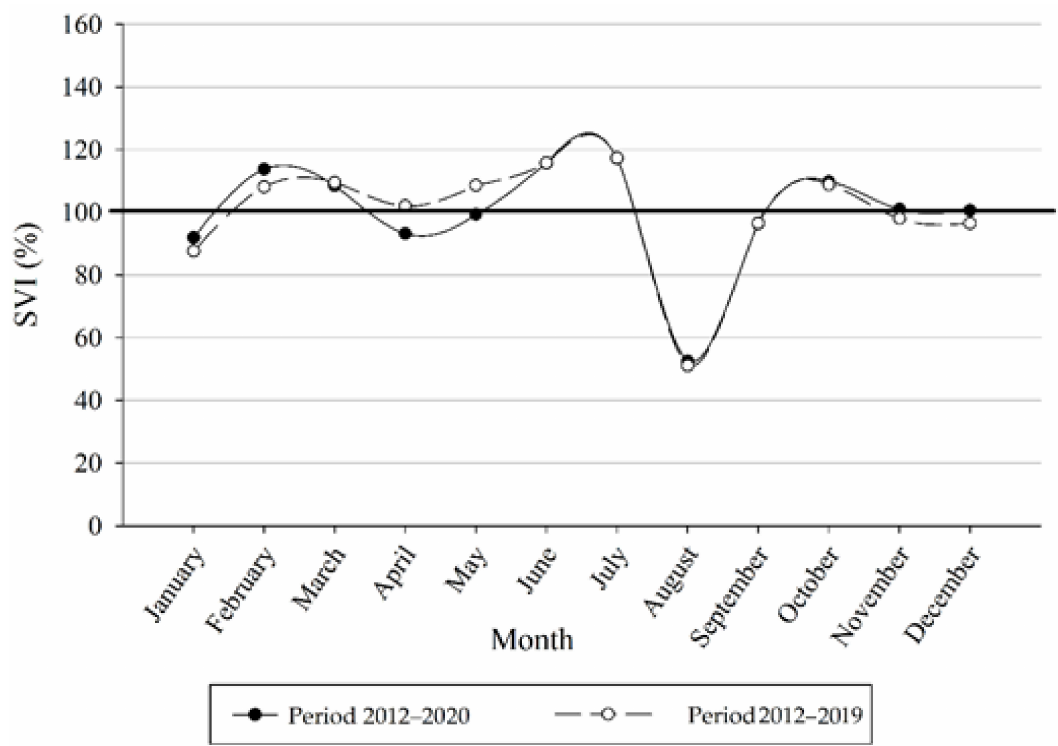
Figure 22. Seasonality pattern of vehicle embarking traffic of the port of Vigo during the periods 2012–2019 and